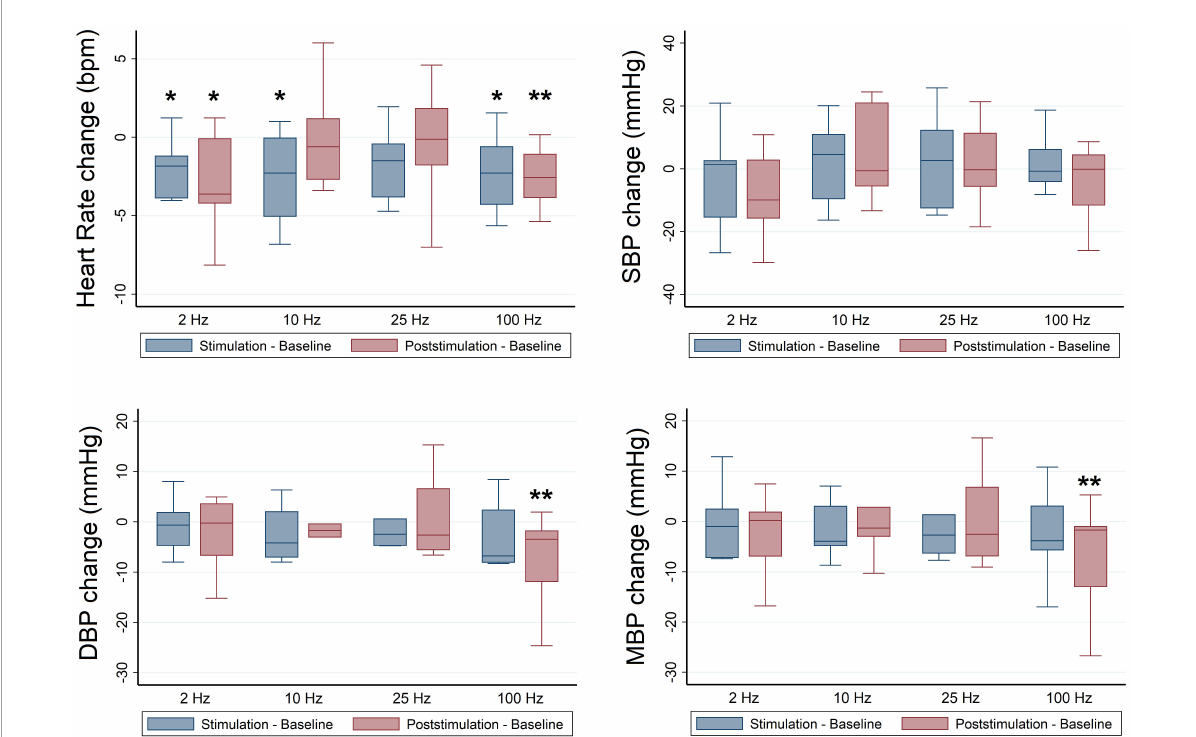
FIGURE3 Frequency-dependent effects of RAVANS on the regulation of heart rate, systolic blood pressure (SBP), diastolic blood pressure (DBP), and mean blood pressure (MBP) in Black participants included in the study. Changes in variables estimated as absolute difference from baseline in comparison with sham stimulation. * p < 0.05, ** p <